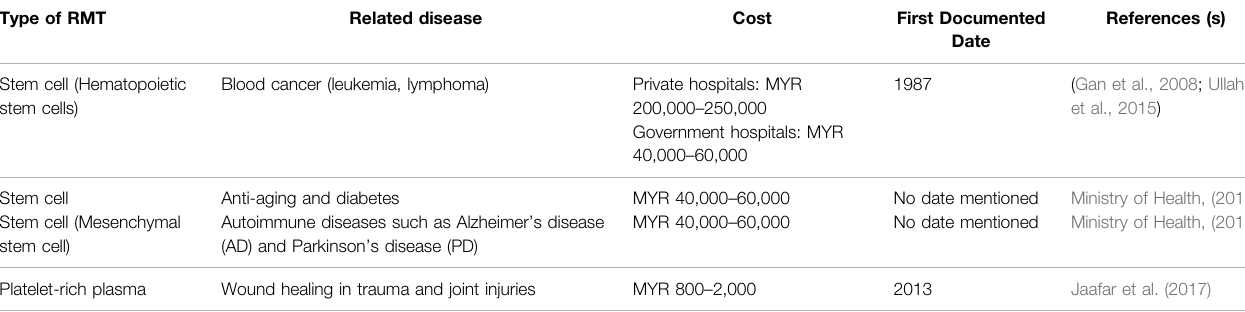
TABLE 2 | Regenerative medicine therapy in